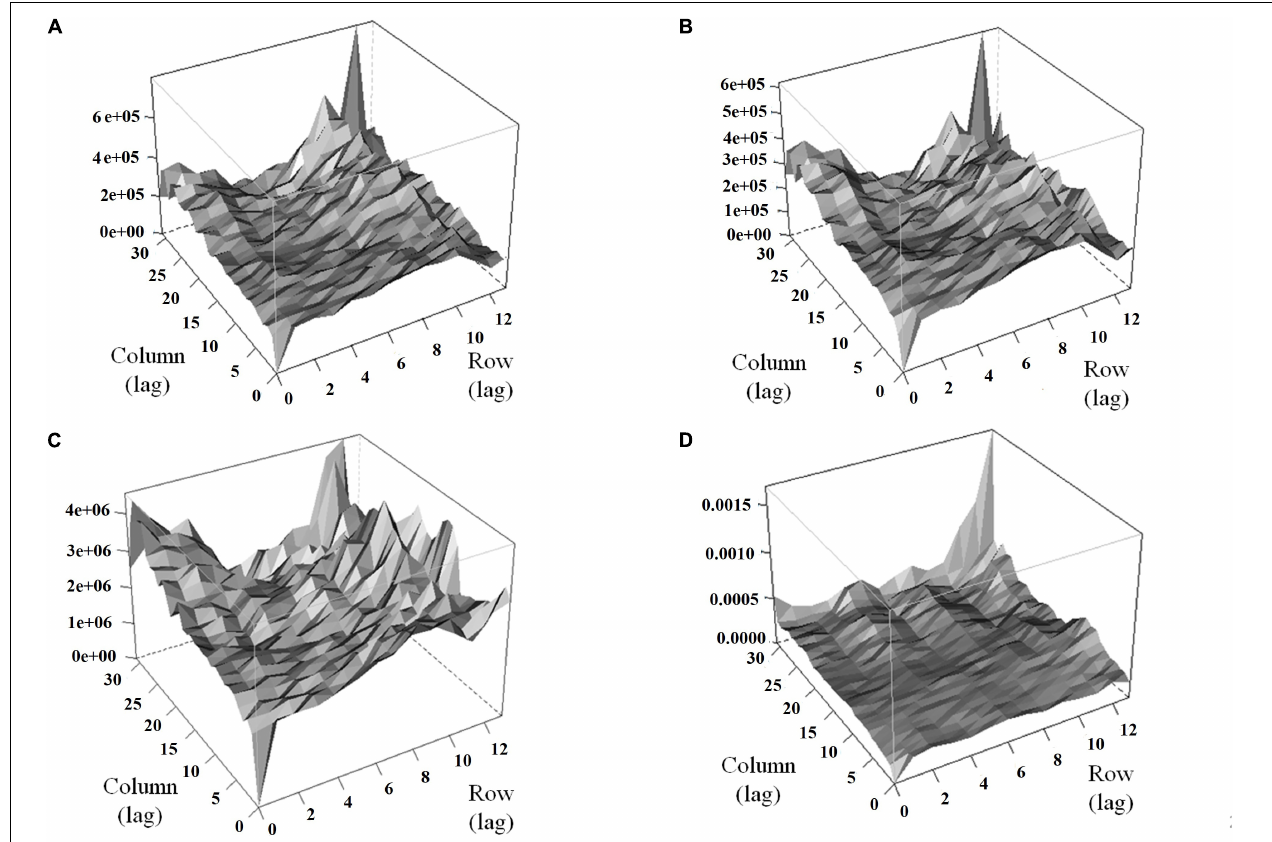
FIGURE 5 | Variograms for HA and normalized difference vegetation index (NDVI) before (A,C) and after (B,D) the inclusion of terms to control local and global trends for alfalfa yield in harvest one in alfalfa families evaluated in Citra, FL. (A) HA-based model, (B) HA-spatial model, (C) NDVI-based model, (D) NDVI-spatial model. Row and column are coordinates for the rows and columns in the experimental area,